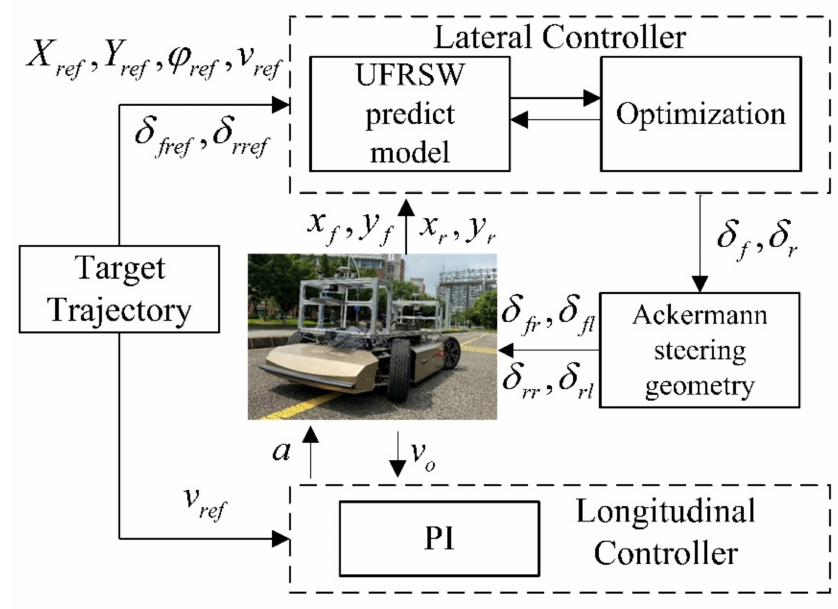
Figure 1. Trajectory tracking controller framework